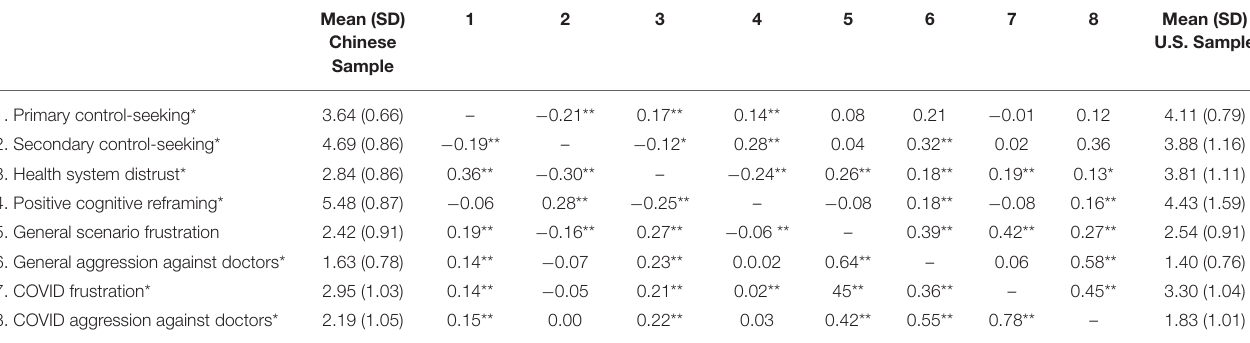
TABLE 3 | Within–country zero-order correlations and descriptives (Study